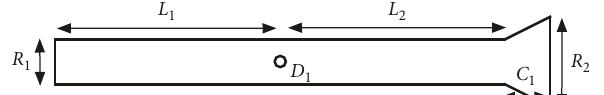
+ L + C � 20 π ; the 1 2 1